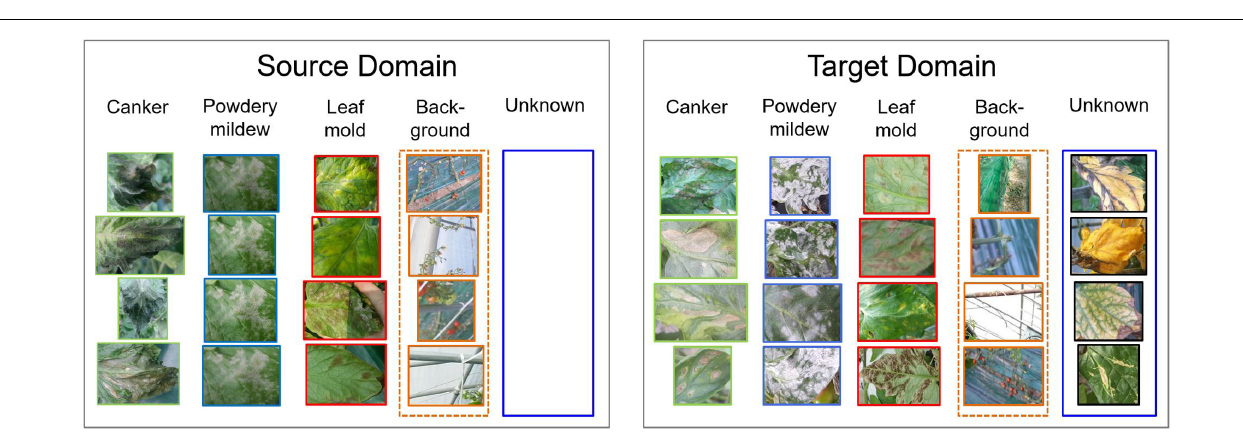
FIGURE 3 | Open set domain adaptation settings. Unknown data is presented only in the target domain. Data from the source and target domains come from different farms, therefore data variation is evident. Additionally, a background class is included to provide contextual information of the